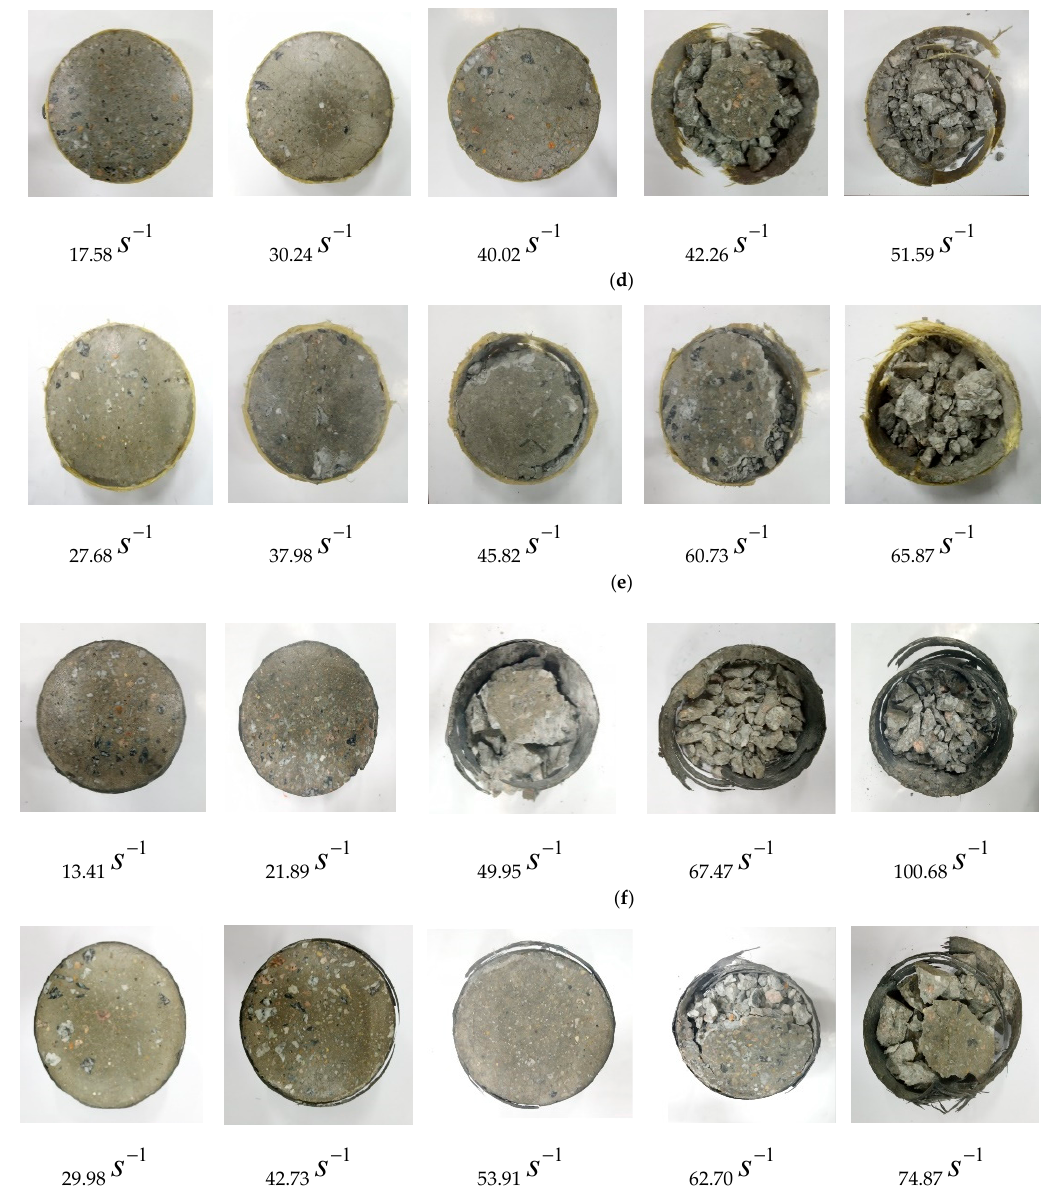
Figure 8. Typical failure modes of FRP-confined and unconfined high-strength concrete specimens under impact loading. ( a ) Typical failure mode of unconfined high-strength concrete specimens under dynamic compression loadings; ( b ) Specimens with a one-layer BFRP jacket; ( c ) Specimens with a three-layer BFRP jacket; ( d ) Specimens with a one-layer AFRP jacket; ( e ) Specimens with a three-layer AFRP jacket; ( f ) Specimens with a one-layer CFRP jacket; and ( g ) Specimens with a three-layer CFRP jacket.